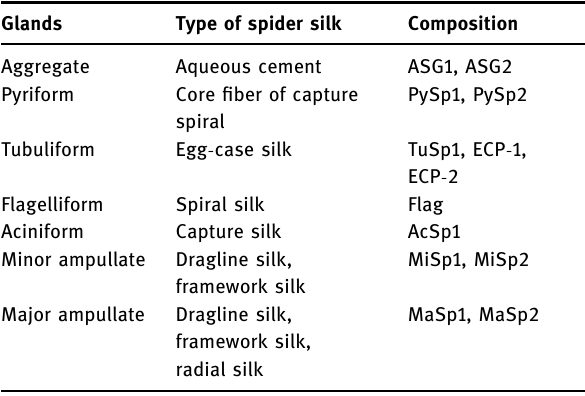
Table 2: Types and composition of spider silk secreted by di ff